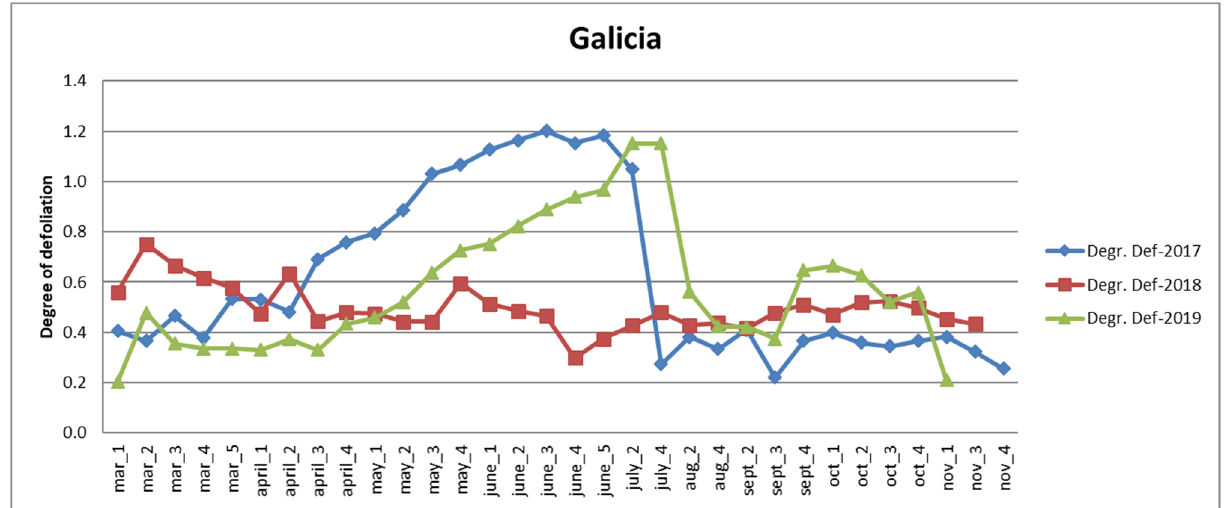
Figure 5. Evolution of the degree of defoliation according to the week of the sampling month (visit).